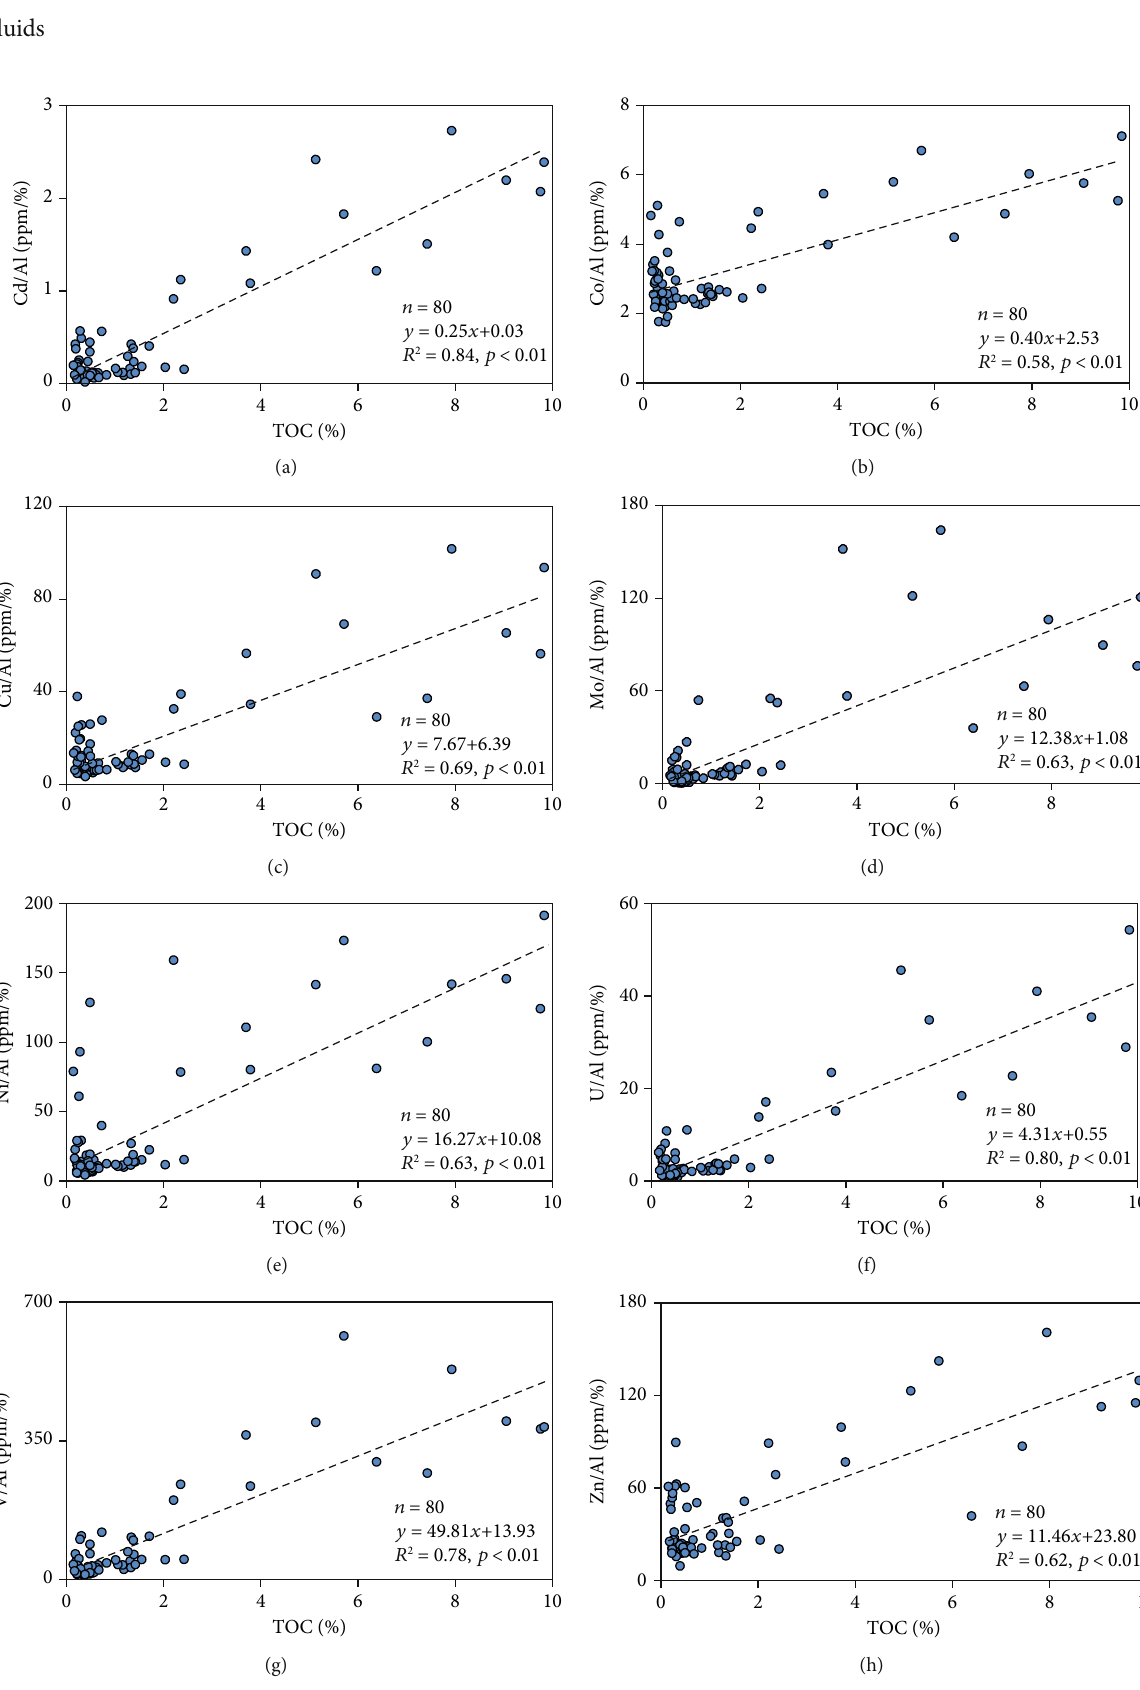
Figure 4: Crossplots of (a) Cd/Al, (b) Co/Al, (c) Cu/Al, (d) Mo/Al, (e) Ni/Al, (f) U/Al, (g) V/Al, and (h) Zn/Al versus